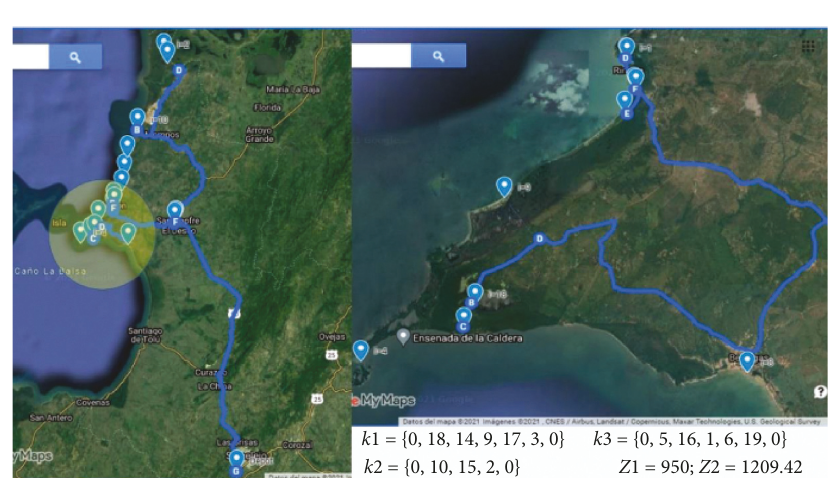
Figure 3: Example itinerary for Toptw-jMunf